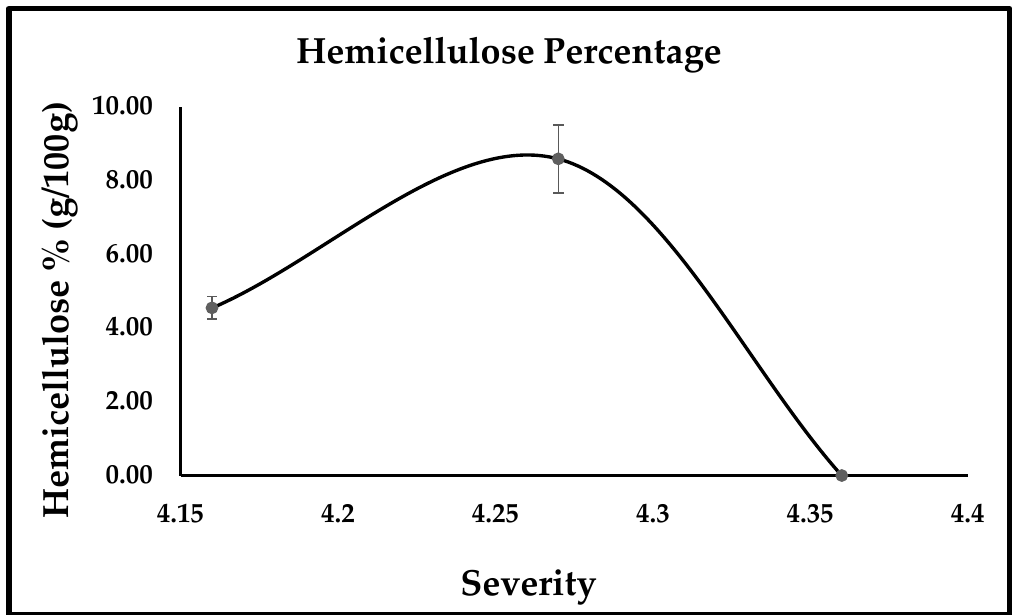
Figure 4. Hemicellulose percentage (g/100 g). The highest glucan percentage obtained was 43.10% at 185 °C for 10 min. The glucan percentage at 155 °C for 50 min was 38.22 ± 1.32%, but this result is in contrast to 170 °C when the cellulose percentage was lower than that of the raw material. The reason for the lower cellulose percentage loss at low temperatures is that at 150 °C or lower tempera- tures, the cellulose percentage loss is low because the degree of polymerization (DP) of cellulose is higher at that temperature [30,31]. By raising the temperature above 160 °C, more cellulose becomes solubilized, resulting in increased cellulose loss [31], which ex- plains why at 170 °C the cellulose percentage was 22.47 ± 1.43, 25.49 ± 1.33, 28.68 ± 1.72, which is lower than the cellulose percentage, i.e., 31.12 ± 1.21% obtained in the raw mate- rial. However, a reduction in cellulose loss is observed when the temperature is increased above 170 °C, as at 185 °C for 10, 30, and 50 min the cellulose percentage was 43.10 ± 2.07, 34.34 ± 0.89, and 40.28 ± 2.91, respectively. According to Ma et al. [31], the possible expla- nation for this could be described in two phases, which are an accelerated initial part, and a slower second part. The variation in the rate of cellulose is due to characteristic varia- tions in cellulose reactivity. This is because the short chains of cellulose that are reactive solubilize quickly and hence cause speedy loss of cellulose. The long chain of cellulose that happens to be less reactive is accountable for the slower second part at the later phase [31]. The glucan percentage at 185 °C for 30 min (34.39 ± 0.89%) is less than the glucan percentage at 185 °C for 50 min (40.28 ± 2.91%). Glucooligosaccharide (GOS) concentration is slightly higher at 185 °C for 30 min than the GOS concentration at 185 °C for 50 min (Refer Table 1). This is because around 3.7% of glucan solubilizes or dissolves in the form of GOS obtained from β -1,3-1,4-glucan [32], and this could be the probable cause for the low glucan percentage at 185 °C for 30 min. In crystalline cellulose, the increased temper- ature causes intermolecular hydrogen bond cleaving. In addition, with the annealing pro- cess, I α transforms to I β with better thermodynamic stability [30]. The following could be